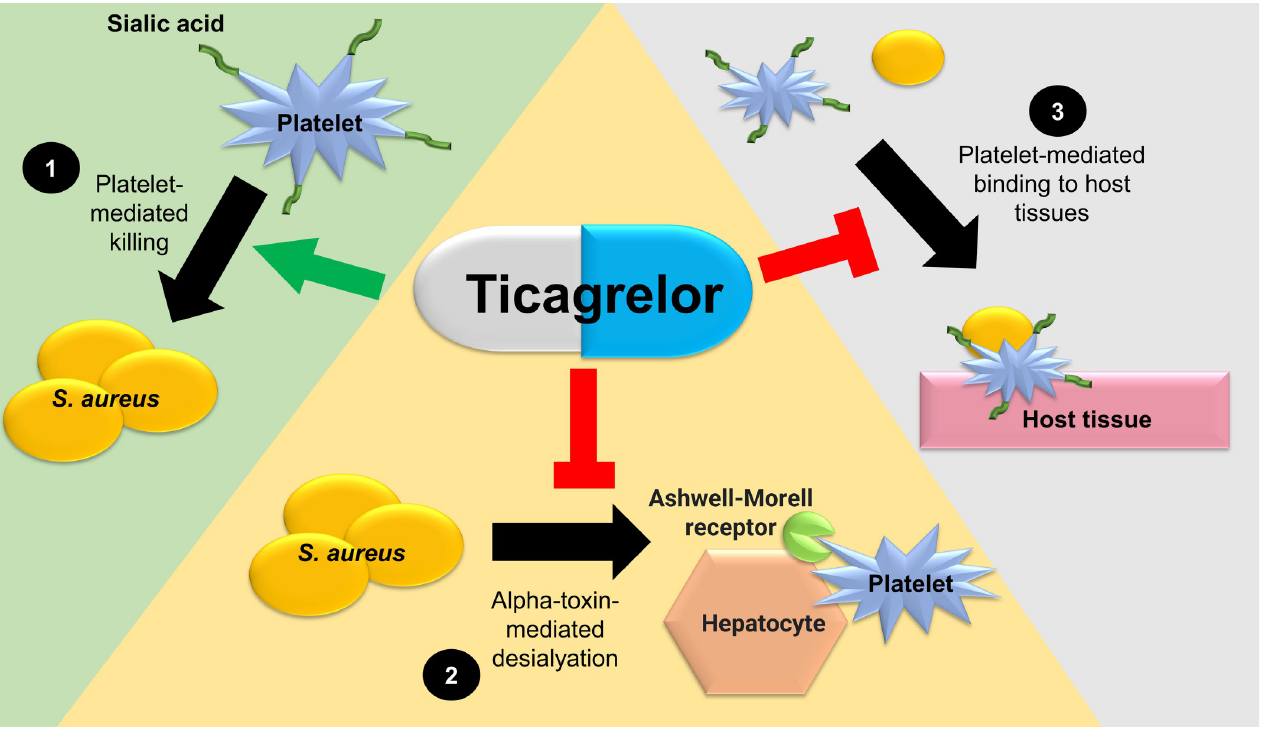
Fig 1. Schematic of proposed pathways in which ticagrelor may affect S . aureus infection (not to scale): (1) enhancement of platelet-mediated S . aureus killing; (2) prevention of α -toxin–mediated platelet desialyation and subsequent removal from circulation via the hepatic Ashwell–Morell receptor; and (3) inhibition of S . aureus binding to host tissues via adhered